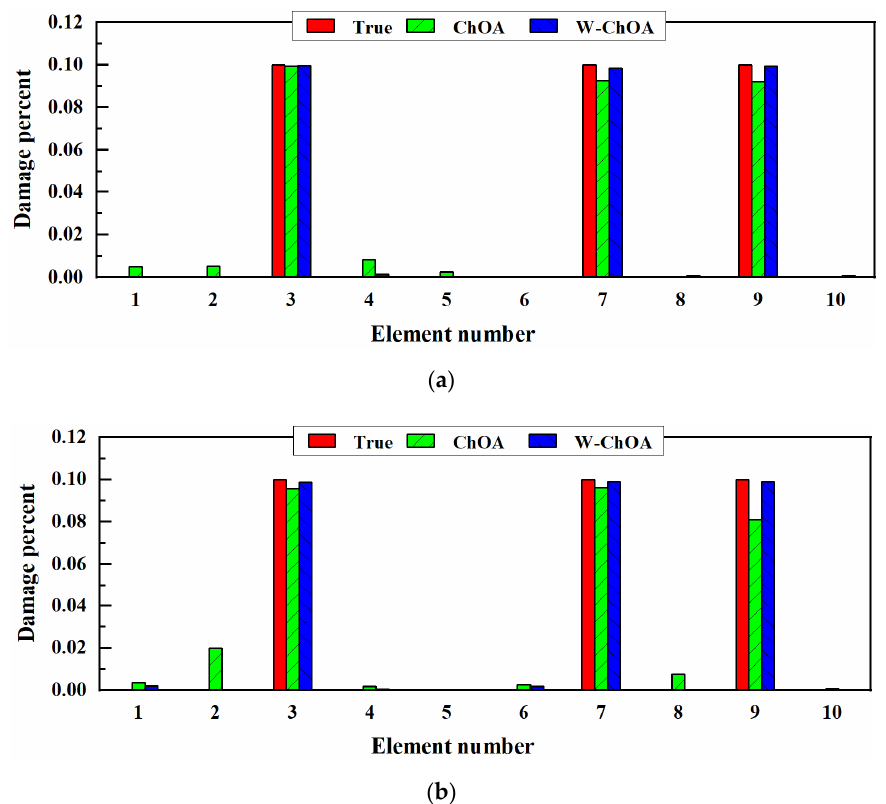
Figure 11. Triple damages detection results of the simply supported beam by two chimp-based optimization algorithms. ( a ) 5% noise level. ( b ) 10% noise